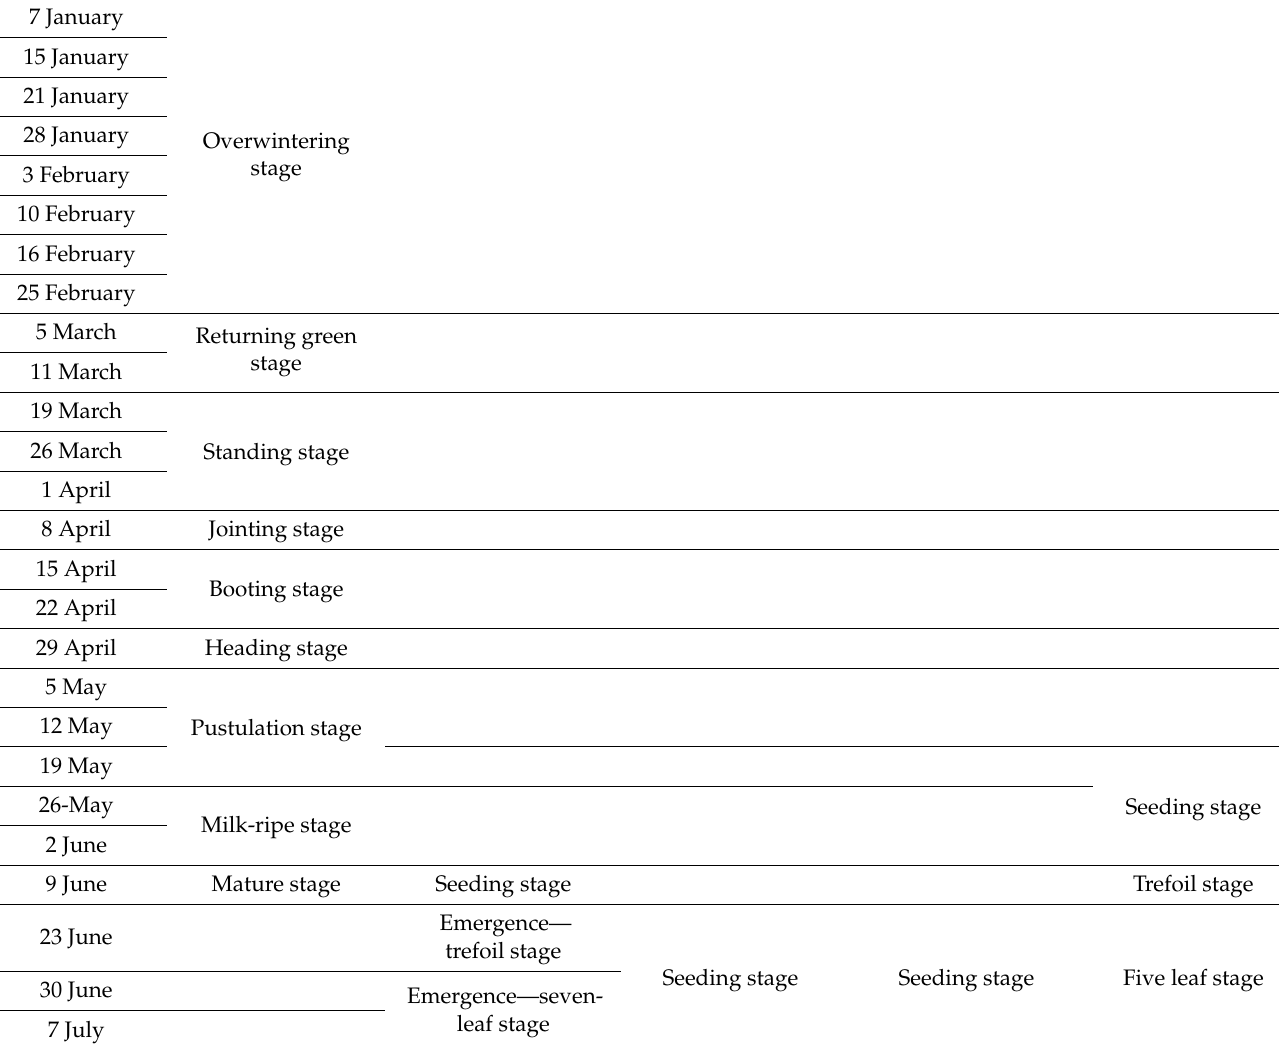
Table 3. Crop phenology. This data is based on observations of crop growth every seven days. Corn Millet